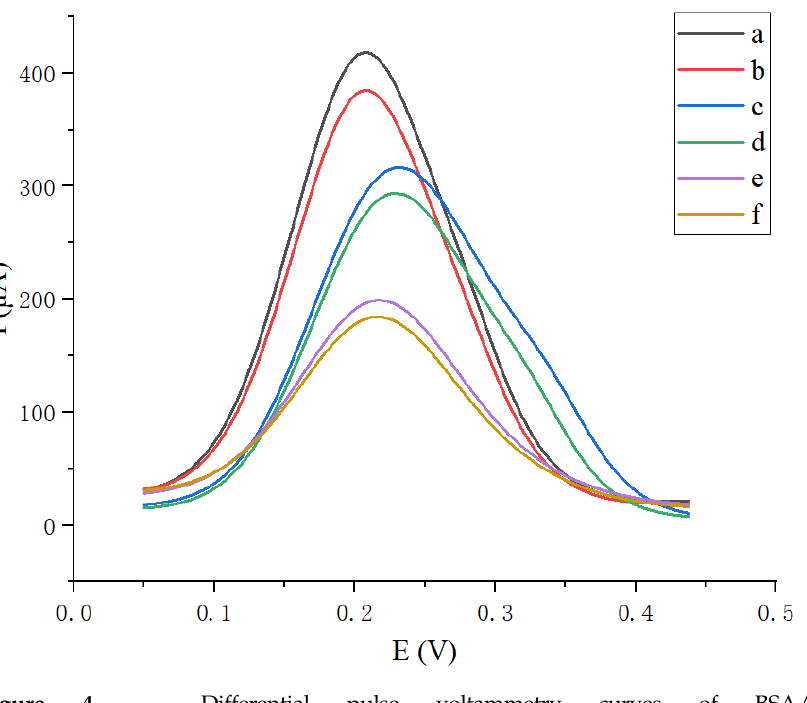
Figure 4. Differential pulse voltammetry curves of BSA/Anti-CA125/N-rGO@CMWCNTs/CS@AuNPs/GCE (curve a ), CA125/BSA/Anti-CA125/N-rGO@CMWCNTs/CS@AuNPs/GCE (curve b ), BSA/Anti-CA125/CMWCNTs/CS@AuNPs/GCE (curve c ), CA125/BSA/Anti-CA125/CMWCNTs/CS@AuNPs/GCE (curve d ), BSA/Anti-CA125/N-rGO/CS@AuNPs/GCE (curve e ) and CA125/BSA/Anti-CA125/N-rGO/CS@AuNPs/GCE (curve f ).